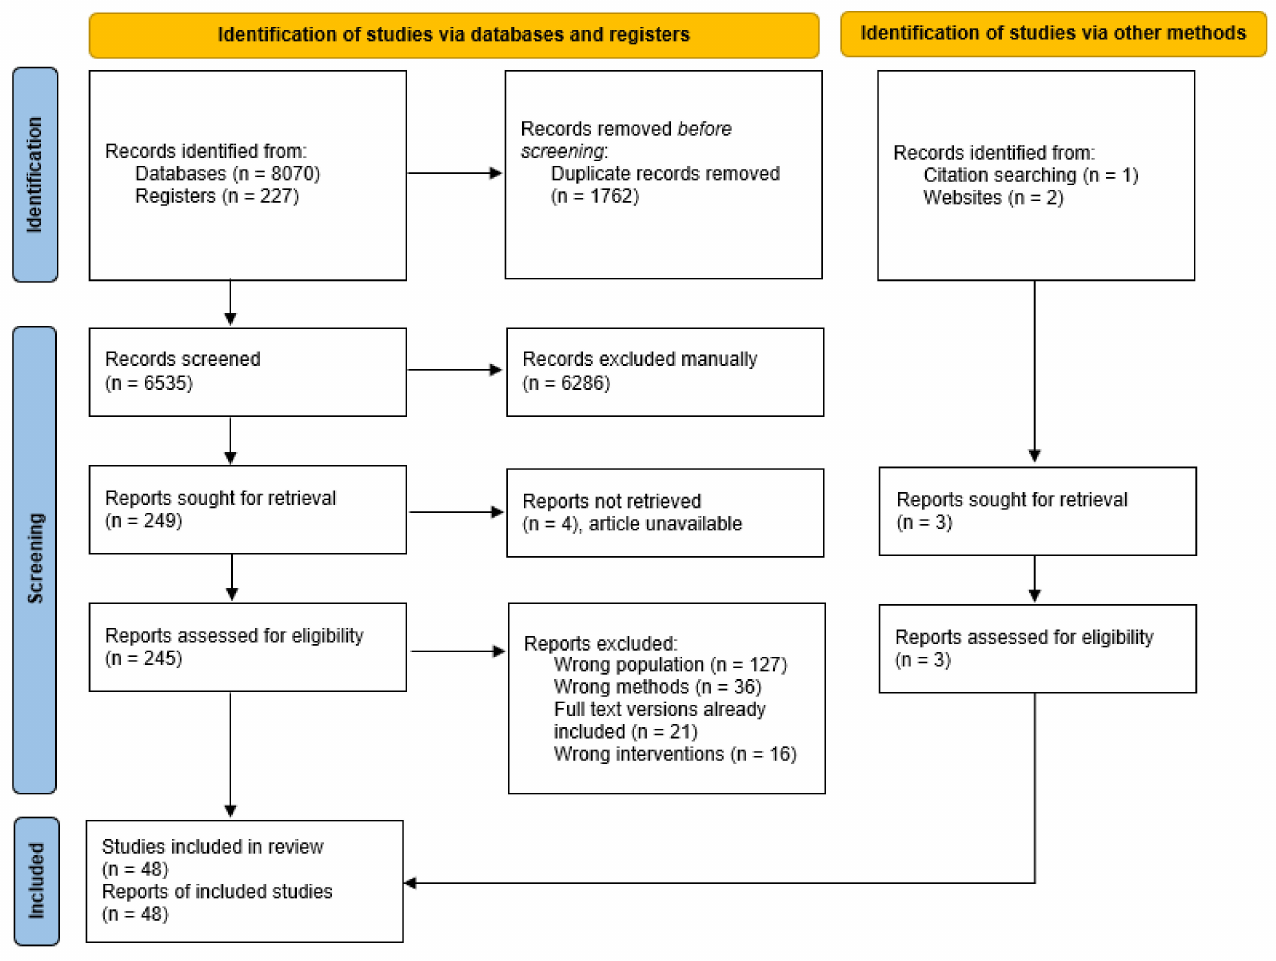
Figure 1. Preferred Reporting Items for Systematic Reviews and Meta-analyses (PRISMA 2020) flow